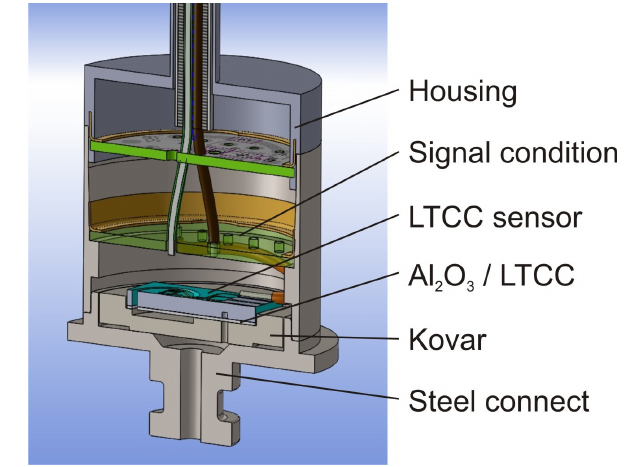
Figure 1. LTCC pressure transmitter and corresponding drawing of inner setup.